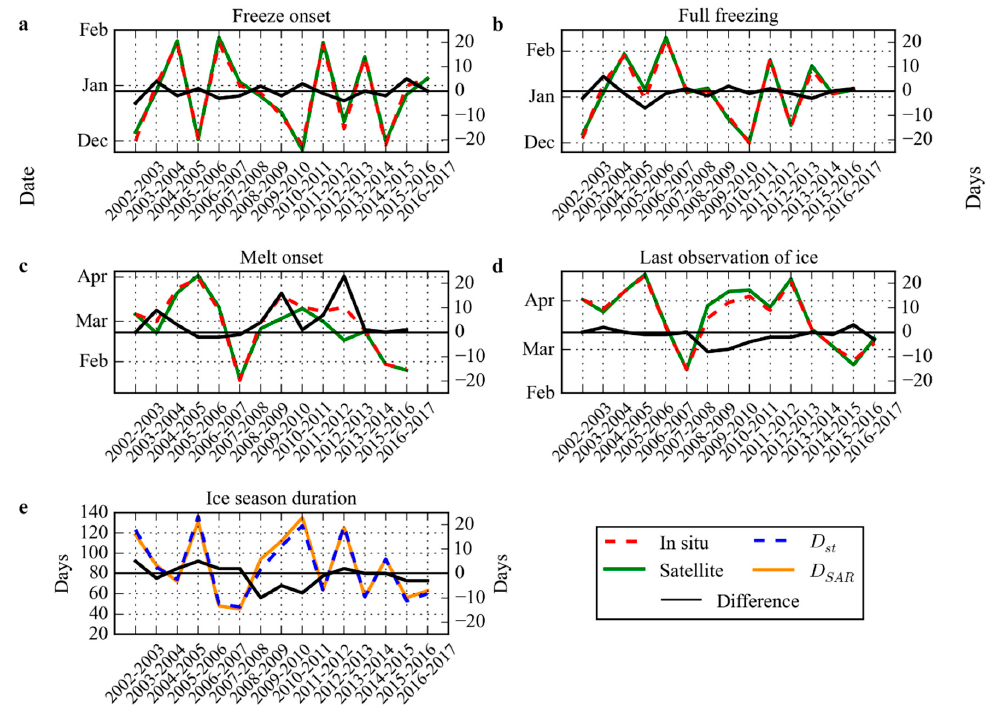
Figure 2. Intercomparison of the ( a ) freeze onset (FO), ( b ) full freezing (FF), ( c ) melt onset (MO), ( d ) last observation of ice cover (LOI) dates, and ( e ) ice season duration ( D st and D SAR ) derived from the satellite observations (solid lines) and in situ records (dashed lines), and the time di ff erence between them (black solid line).